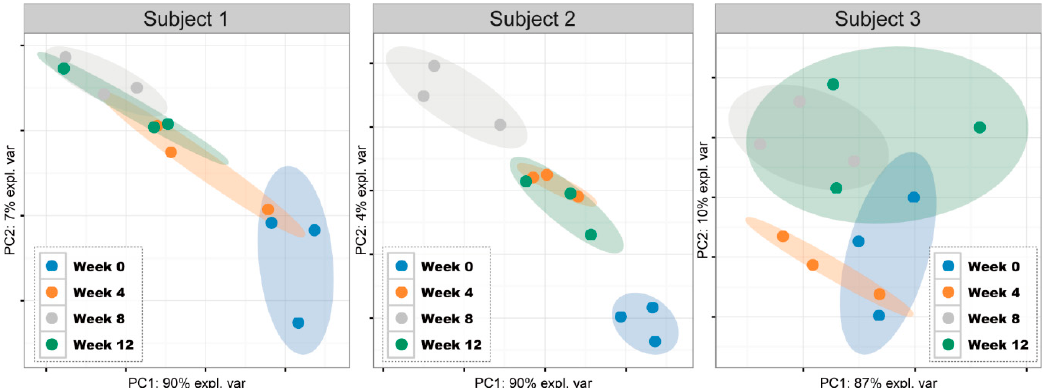
Figure 2. Principal component analysis (PCA) score plots based on the relative abundance of all operational taxonomic units (OTUs) of each subject.